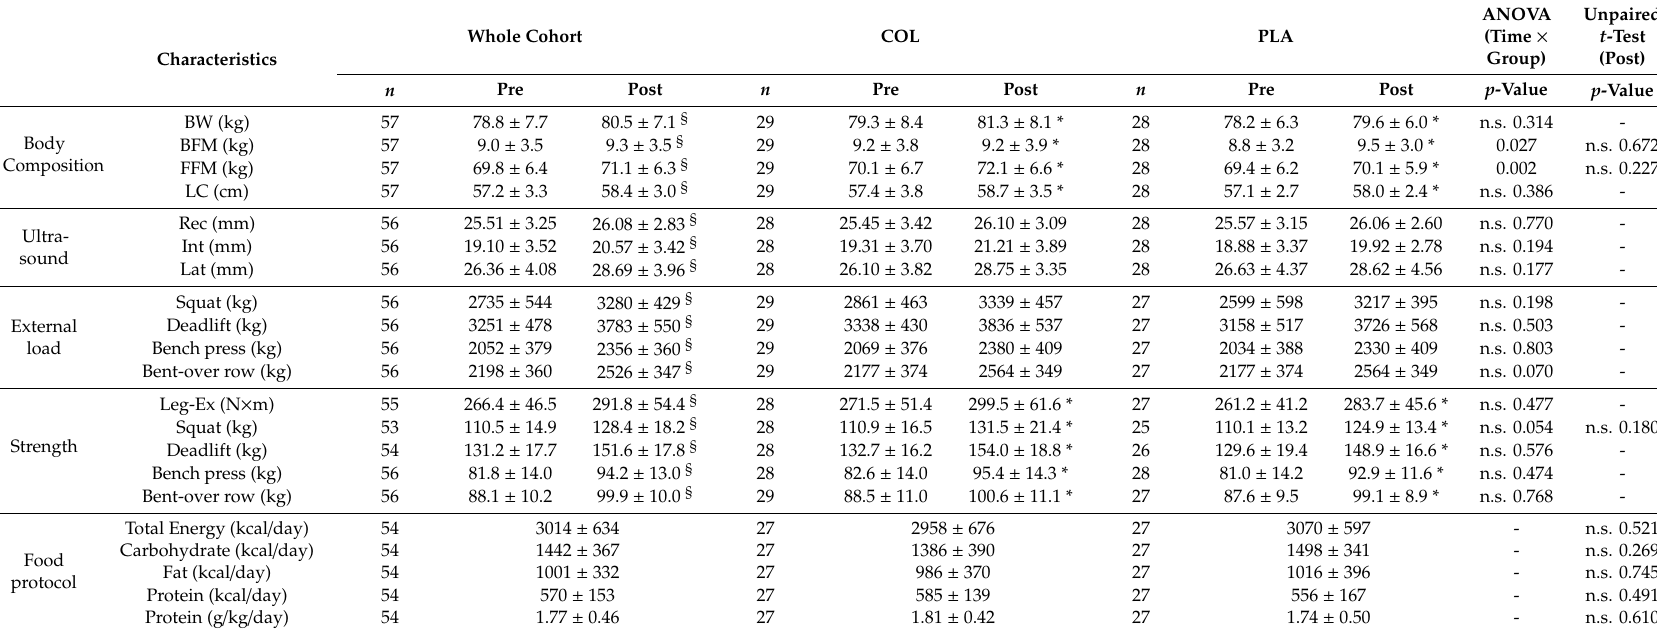
Table 1. Data of body composition, ultrasound, external load (from the 4th (pre) to the 32nd (post) training day), and strength of the whole cohort and of the tested groups before (pre) and after (post) a 12-week training period with a collagen peptide (COL) or a placebo (PLA) supplementation. The food protocol was performed during the 12 weeks of training for 3 days and averaged for one day. BW = body weight; BFM = body fat mass; FFM = fat-free mass; LC = leg circumference; Rec = m. rectus femoris; Int = m. vastus intermedius; Lat = m. vastus lateralis; n.s. = not significant ( p > 0.05); * = significantly di ff erent to pre within the respective group (paired t -test, p ≤ 0.05); § = significantly di ff erent to pre of the whole cohort (ANOVA: main e ff ect, p ≤